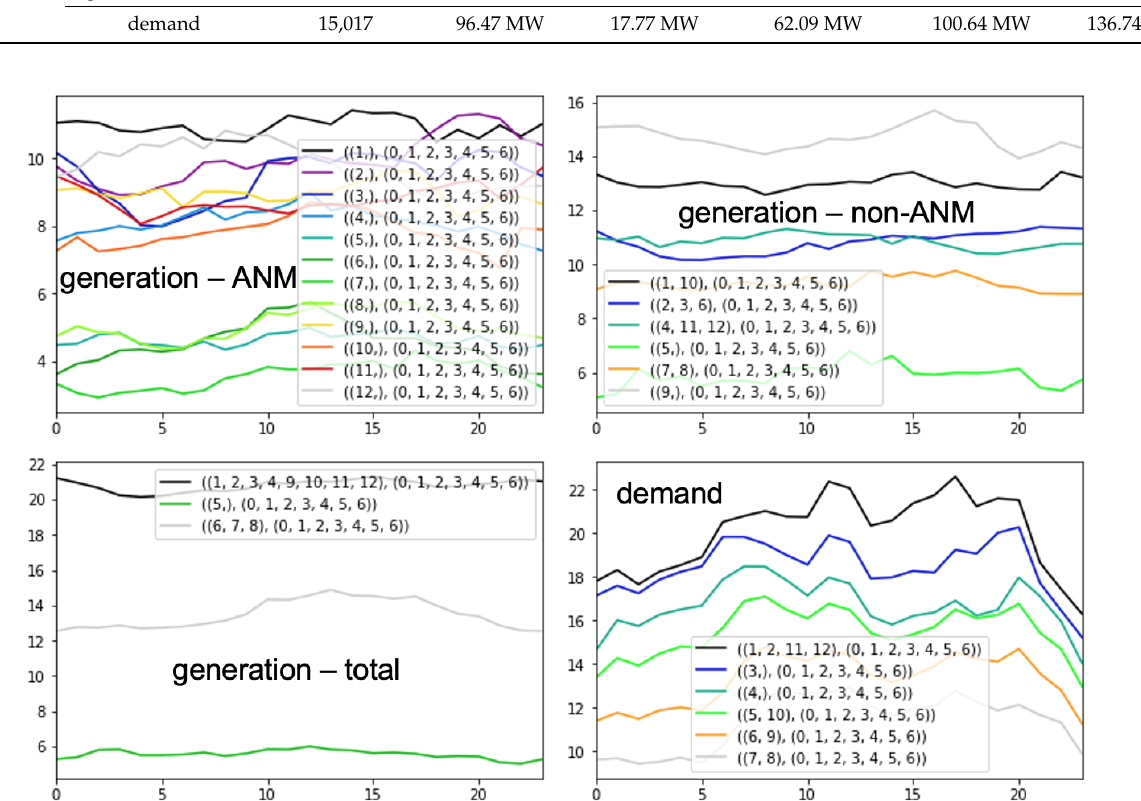
Figure A1. Average time profiles of power data from Orkney. The horizontal axes represent time of the day (h), and the vertical ones power (MW). The legends explain the clustering groups in the form (months, days of week), where days are numbered from 0 (Monday) to 6